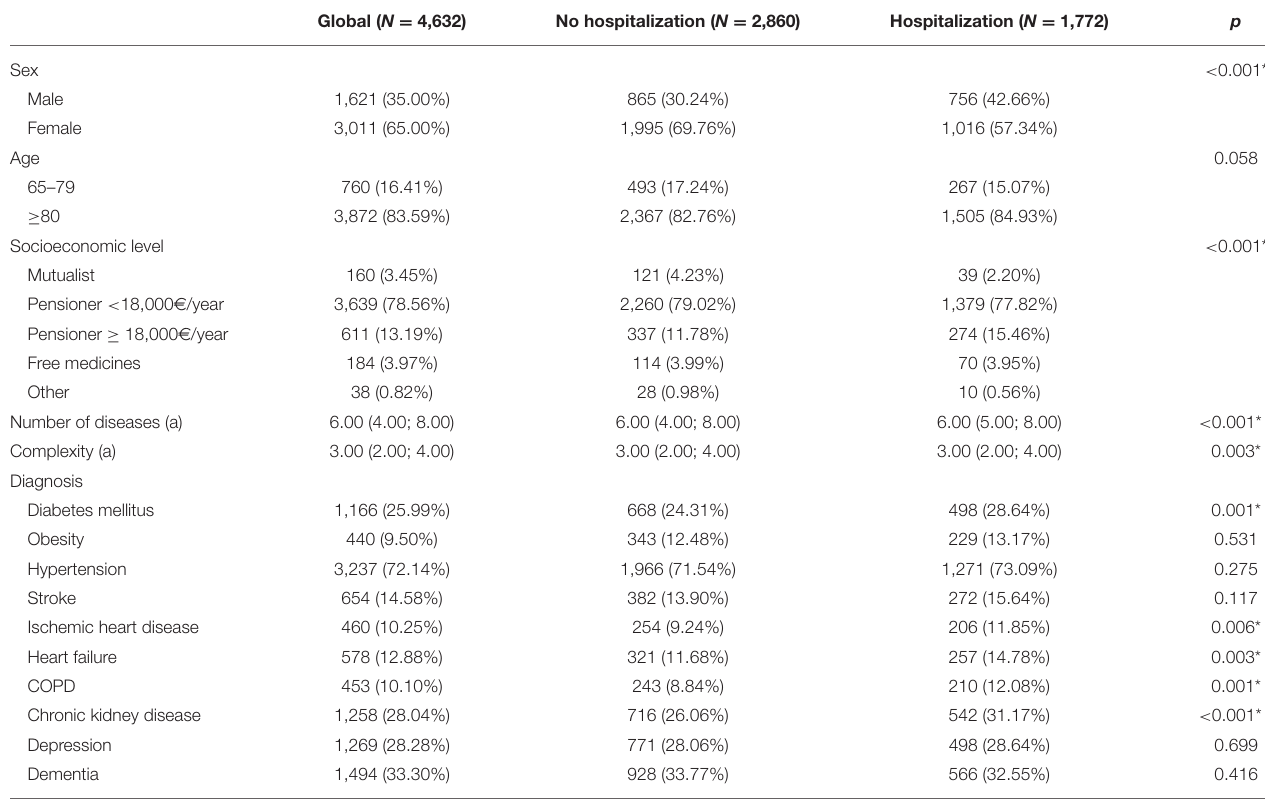
TABLE 1 | Hospitalization in COVID-19 confirmed institutionalized patients over 64 years of age. Global ( N =